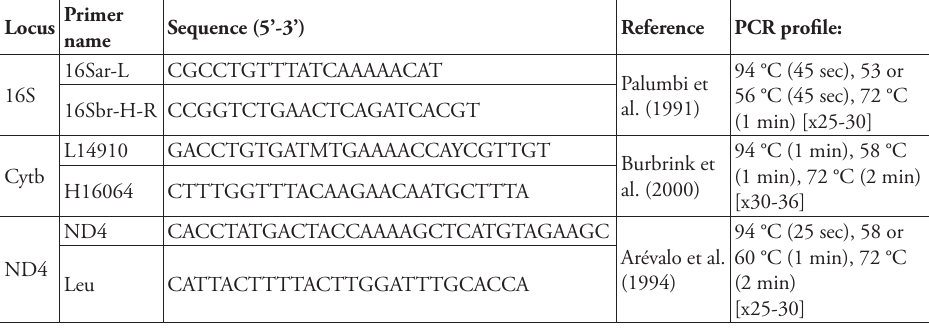
List of PCR and sequencing primers and their respective PCR conditions (denaturation, annealing, exten- sion and number of corresponding cycles) used in this study. All PCR protocols included an initial 3-min step at 94 °C and a final extension of 10 min at 72